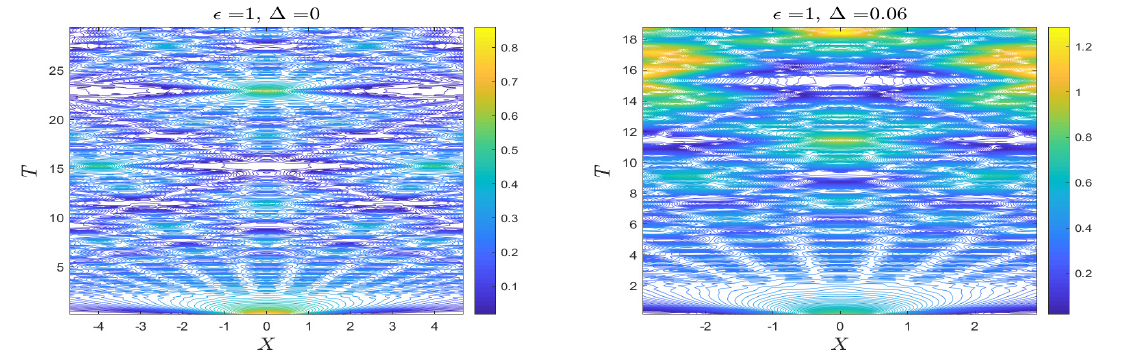
Figure 16. Case 3: The initial condition is (13) with γ = 2.0, (cid:101) = 1.0, M = 1 and ∆ = 0, ∆ =